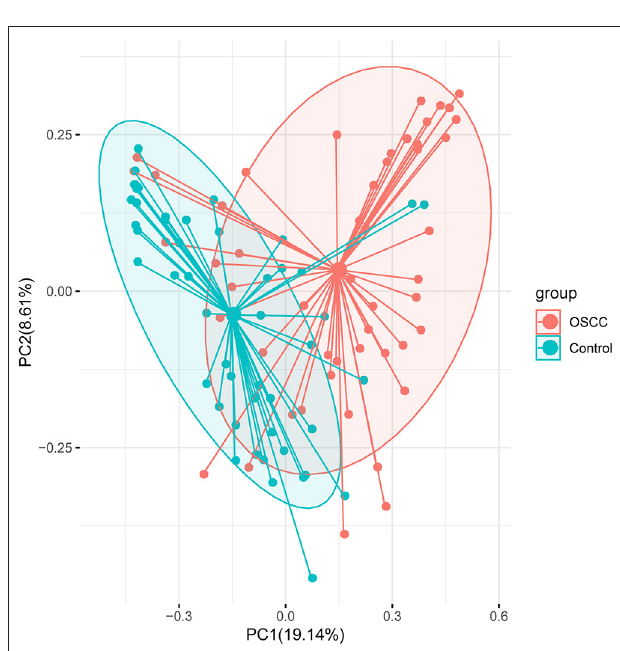
FIGURE 2 | Principal component analysis (PCA) analysis with Bray-Curtis dissimilarity based on genera between the microbiota of the two groups. Points represent samples. Samples that are more similar to one another are ordinated closer together. The groups show significant differences in similarity tested by ANOSIM ( P ANOSIM <